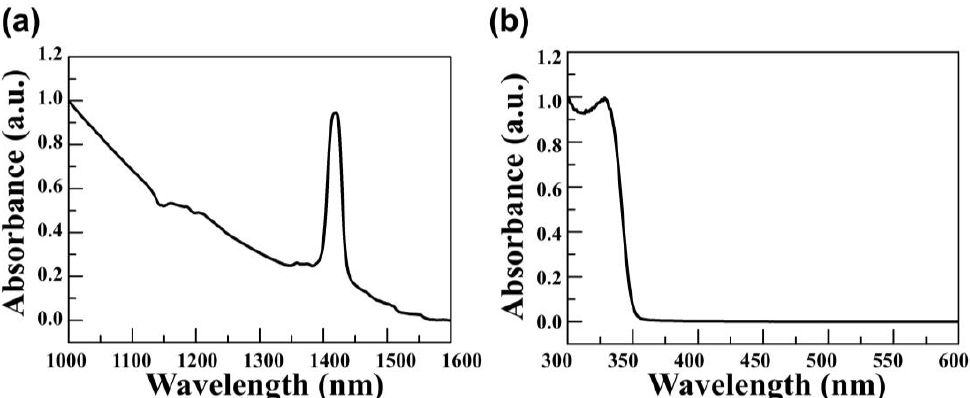
Figure 4. Absorbance spectrum of synthesized nanoparticles: ( a ) PbS quantum dot and ( b ) ZnO nanoparticles.